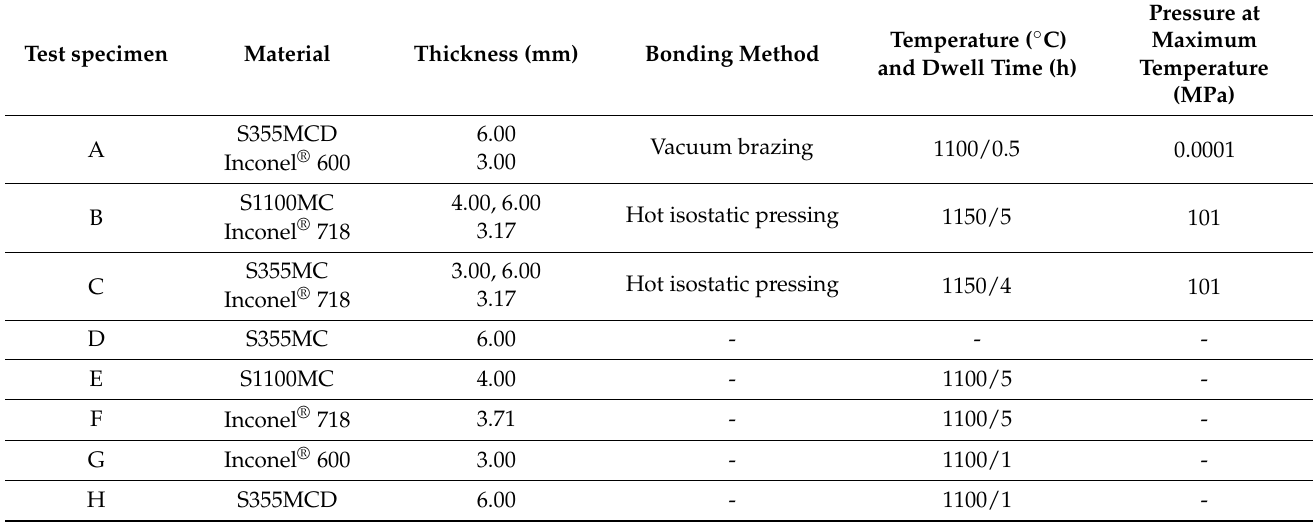
Table 2. Test specimens and their bonding methods and process